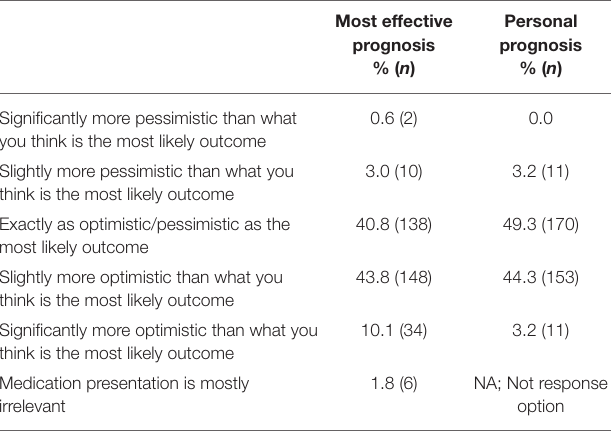
TABLE 2 | Prognosis attitudes and behavior.